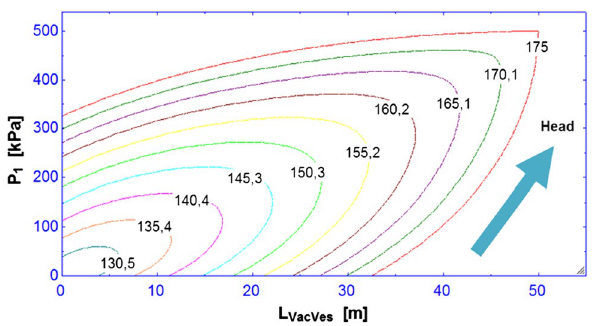
Fig. 18 Pressure and length influence of the